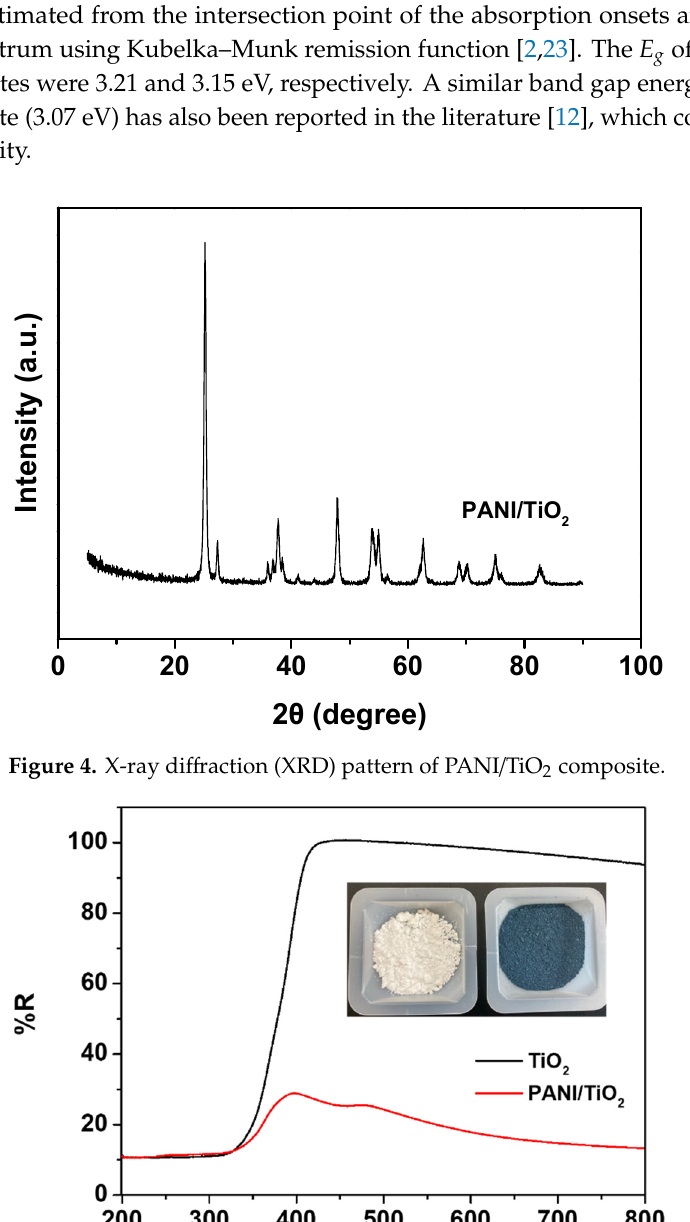
Figure 5. Di ff use reflectance spectra (DRS) spectra of TiO 2 and 4% PANI / TiO 2 composite (insert shows Figure 5. Diffuse reflectance spectra (DRS) spectra of TiO 2 and 4% PANI/TiO 2 composite (insert shows digital image of TiO 2 ( left ) and 4% PANI / TiO 2 composite ( right digital image of TiO 2 ( left ) and 4% PANI/TiO 2 composite ( right )).